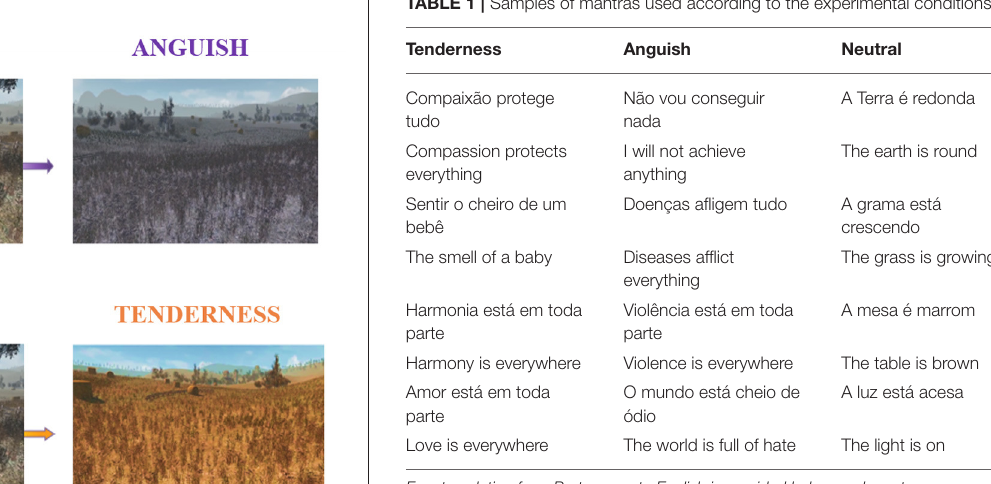
TABLE 1 | Samples of mantras used according to the experimental